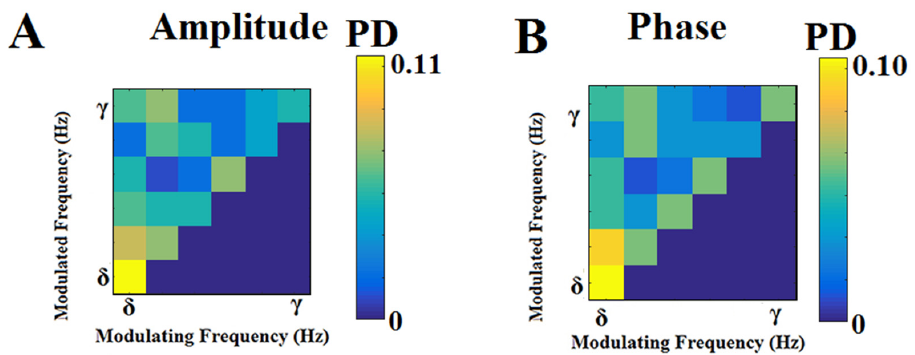
Figure 6. Group-averaged probability distributions (PD) of dominant intrinsic coupling modes